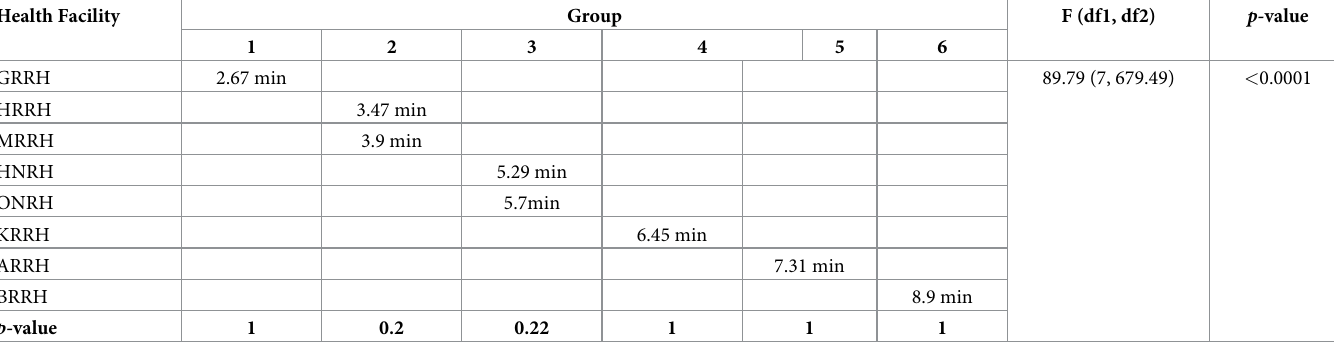
Table 3. Grouping of hospitals as per their homogeneity with regards to the consultation time (minutes). Health Facility